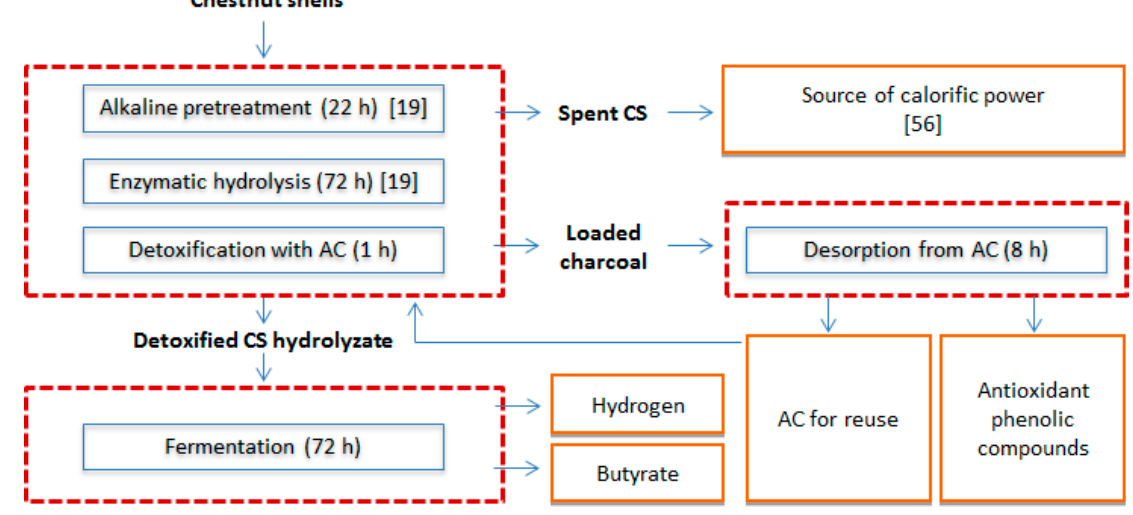
Figure 4. CS biorefinery stages, bioproducts and energy outputs.